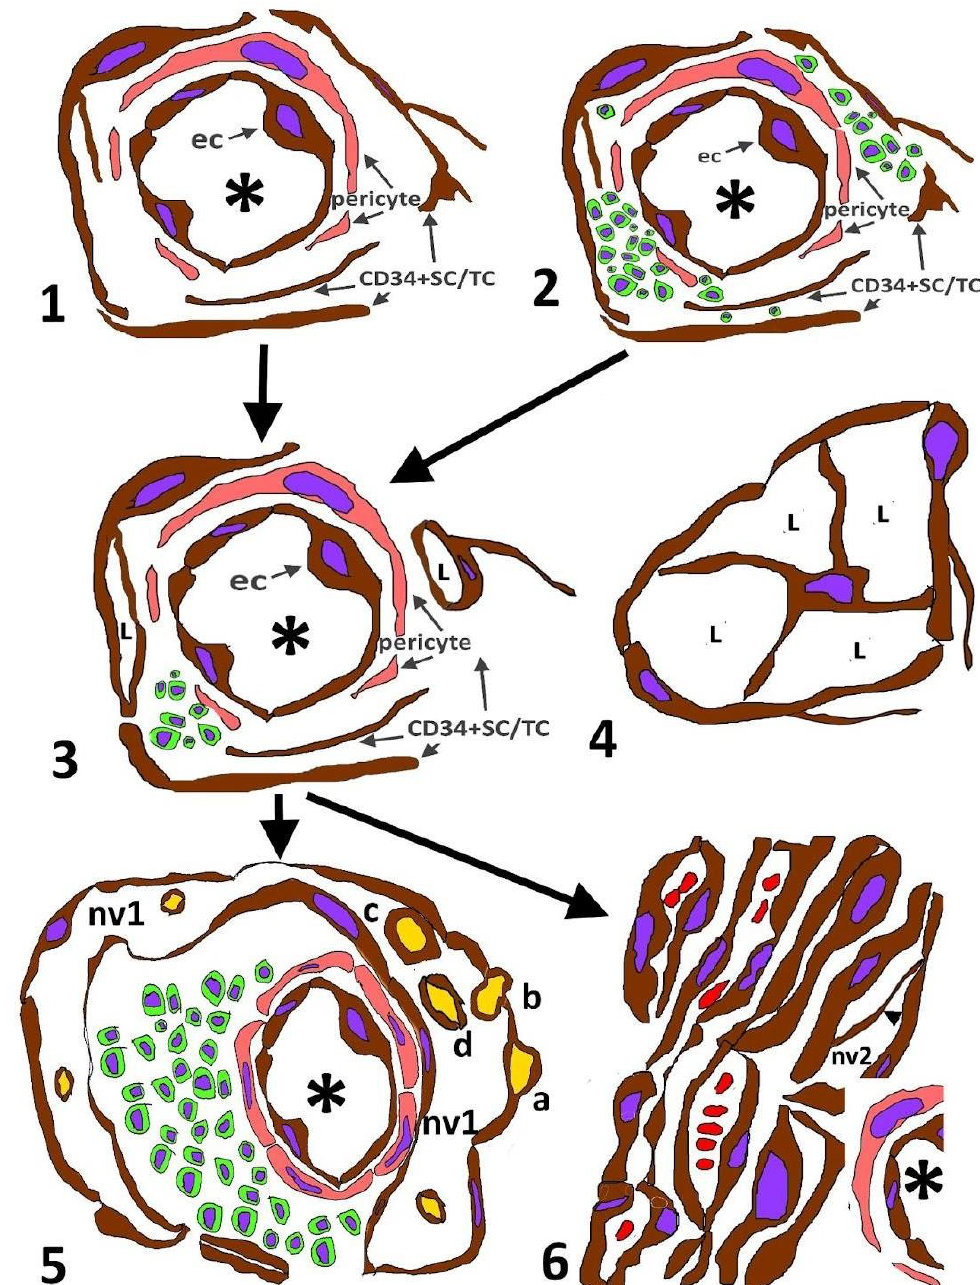
Figure 16. Events of CD34+SCs/TCs during the formation and evolution of neovessels in KS. ( 1 ): CD34+SCs/TCs in the external layer of unaffected pre-existing blood vessels (asterisk). ( 2 ): Perivascular inflammatory infiltrate (cells in green) encompassed by CD34+SCs/TCs. ( 3 ): Formation of small lumens (L) by folded and semi-detached CD34+SCs/TCs. ( 4 ): Detail of a neovessel with an intraluminal stellate CD34+SC/TC, originating new lumens (L). Note that pericytes are absent in the neovessel. Transitional events in the expression of markers and of ultrastructural characteristics between CD34+SCs/TCs and neighboring neovessel ECs occur in this phase, as well as the formation of two types of initial neovessels. ( 5 ): Evolved neovessels type 1 (nv1). Observe a thick fold, including a pre-existing vessel, within a neovessel (promontory sign). Sequential formation of pillars (a,b,c,d) from EC processes surrounding collagen (yellow) until its transport to the neovessel lumen. ( 6 ): Evolved neovessels type 2 (nv2) neighboring to a pre-existing neovessel (asterisk). An EC bridge (arrowhead) is observed in a neovessel.